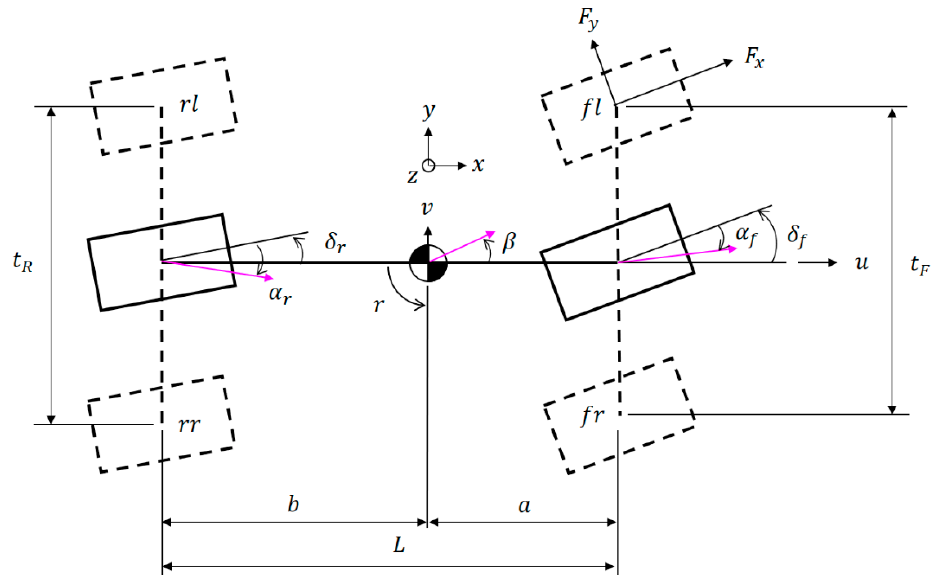
Figure 2. Coordinates of the vehicle dynamics model.